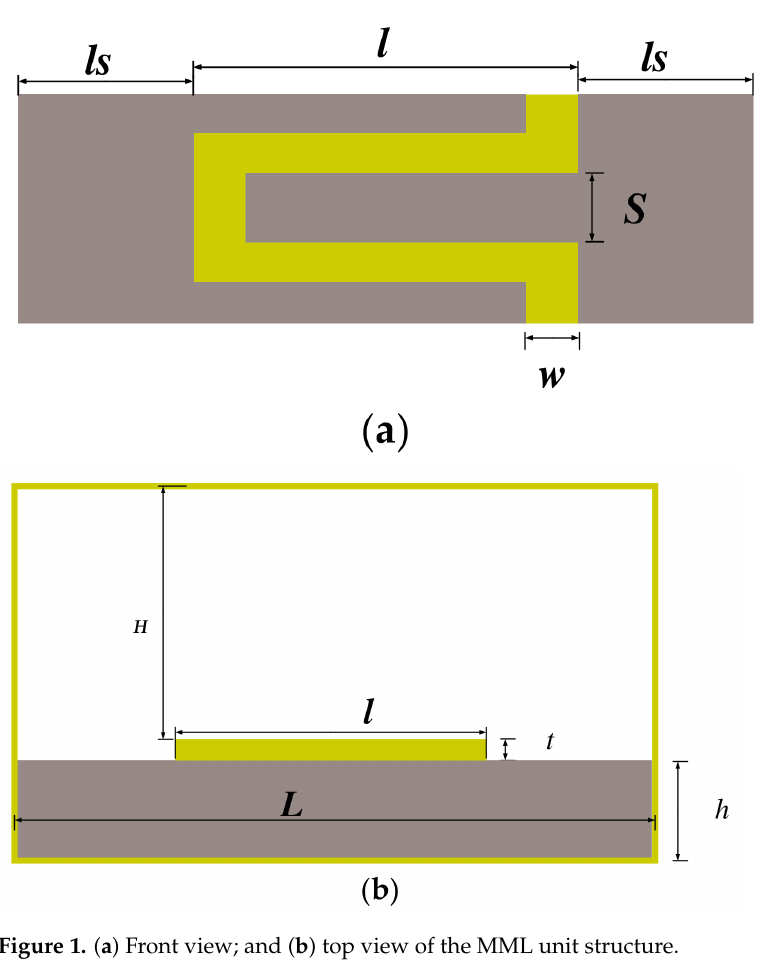
Figure 1. ( a ) Front view; and ( b ) top view of the MML unit structure.